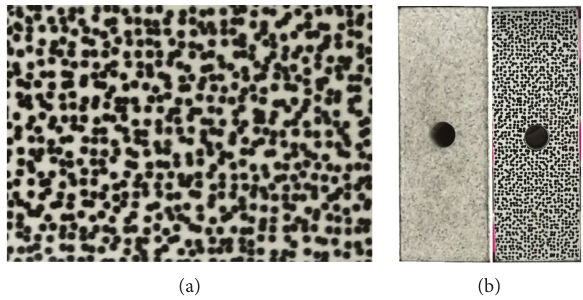
Figure 2: Fabrication of speckles on the specimen surface: special speckle sticker (a) and original specimen and speckled specimen